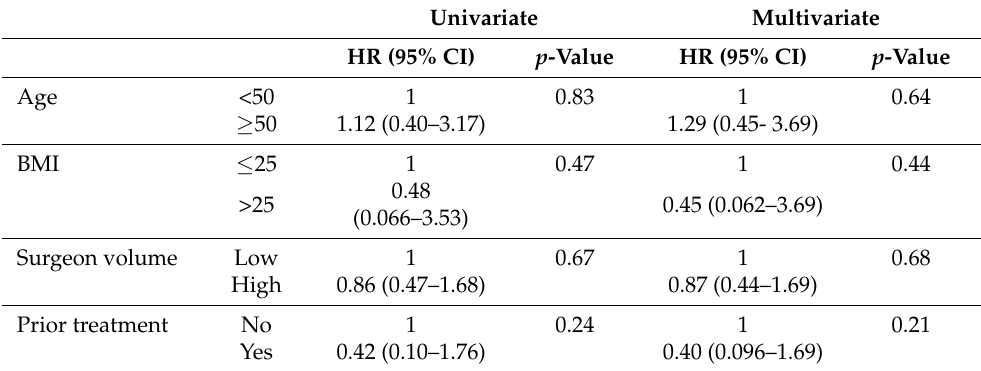
Table 4. Univariate and multivariate analysis of predictive factors for persistence or recurrence.